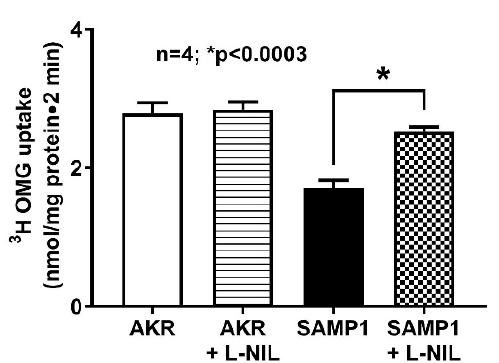
Figure 4. Effect of L-NIL treatment on Na-glucose co-transport in intact villus cells. Na-dependent